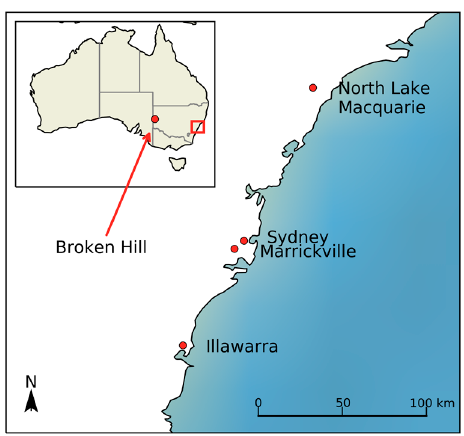
Figure 1. Locator map of four lead exposed New South Wales communities.